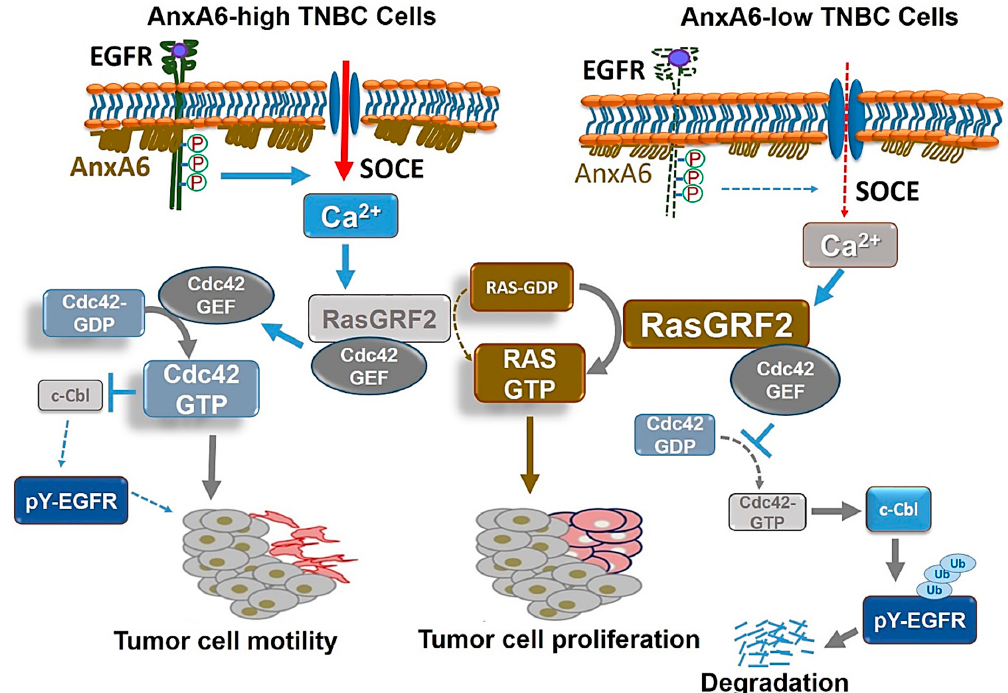
Figure 2. RasGRF2 as an effector of AnxA6 ‐ mediated TNBC cell growth and motility. AnxA6 is a predominantly cytosolic protein but upon an increase in intracellular Ca 2+ levels, it translocates to the plasma membrane where it influences the stability of cell surface receptors, e.g., EGFR and the activity of certain Ca 2+ channels presumably in membrane lipid rafts. In AnxA6 expressing TNBC cells (left panel), prolonged activation of EGFR leads to a sustained increase in store ‐ operated Ca 2+ entry (SOCE) and activation, followed by subsequent degradation of RasGRF2. The resulting decrease in cellular RasGRF2 levels enhances the activation of Cdc42 which inhibits the ubiquitin ligase c ‐ Cbl and leads to the stabilization of activated EGFR on the cell surface. The activation of Cdc42 also sustains persistent cell motility. In AnxA6 ‐ low TNBC cells (right panel), activation of EGFR is not affected but is transient. This leads to reduced SOCE, stabilization of RasGRF2 levels and its interaction of Cdc42 c-Cbl, subsequent ubiquitination of activated EGFR, internalization and degradation by proteasomes. The stabilization of RasGRF2 promotes the activation of the Ras / MAP kinase pathway and enhances